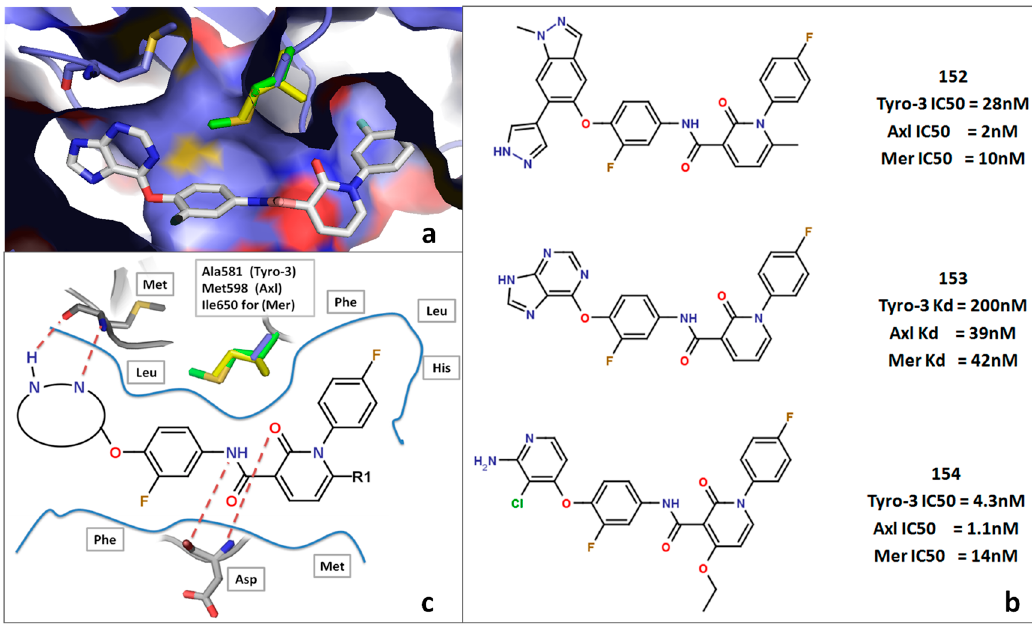
DFG-Asp out model. ( b ) Structure of compounds 152 – 154 with their respective activities against Tyro-3, Axl and Mer. ( c ) General schematic of type II inhibitors docking in the active site of a TAM kinase in the DFG-Asp out